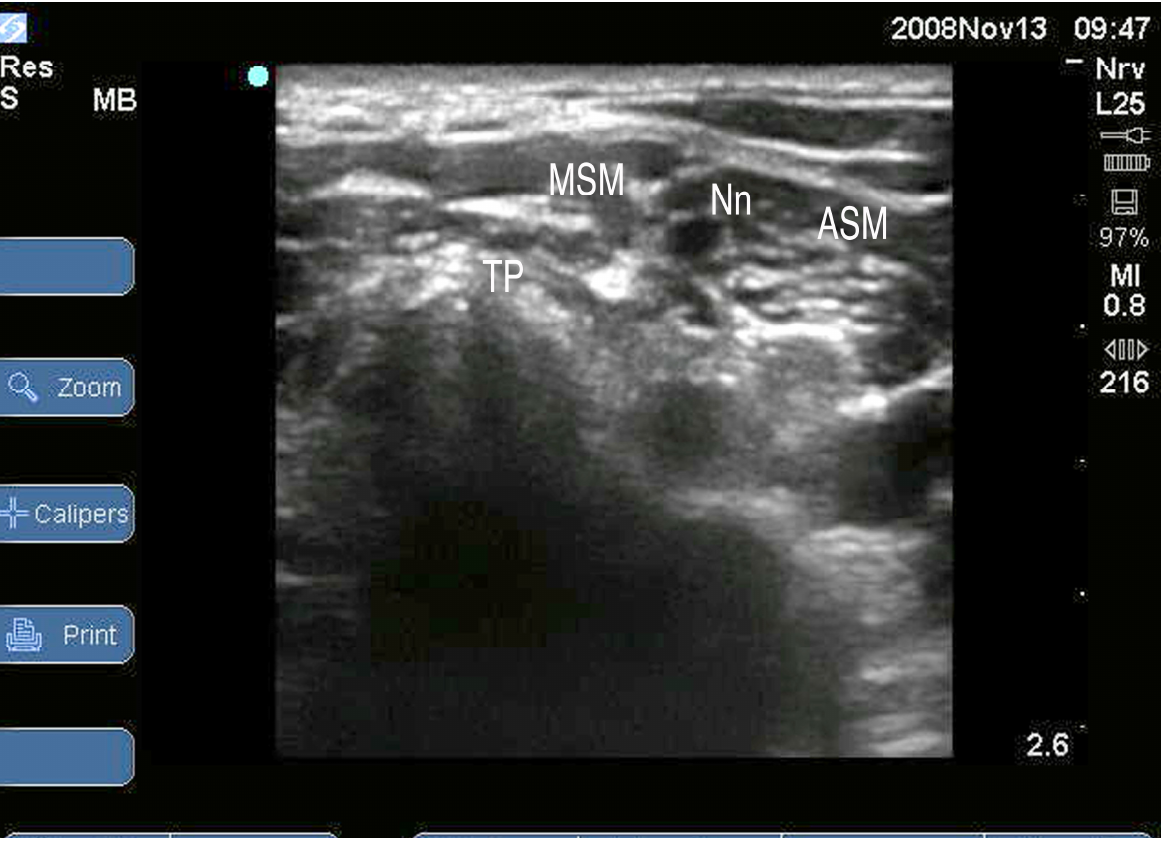
FIGURE 2. Ultrasound of the interscalene region, revealing the hypoechoic, nodular fascicles of the nerves of the brachial plexus, between the scalene muscles. MSM, middle scalene muscle; ASM, anterior scalene muscle; Nn, fascicles of brachial plexus nerves; TP, transverse process of cervical